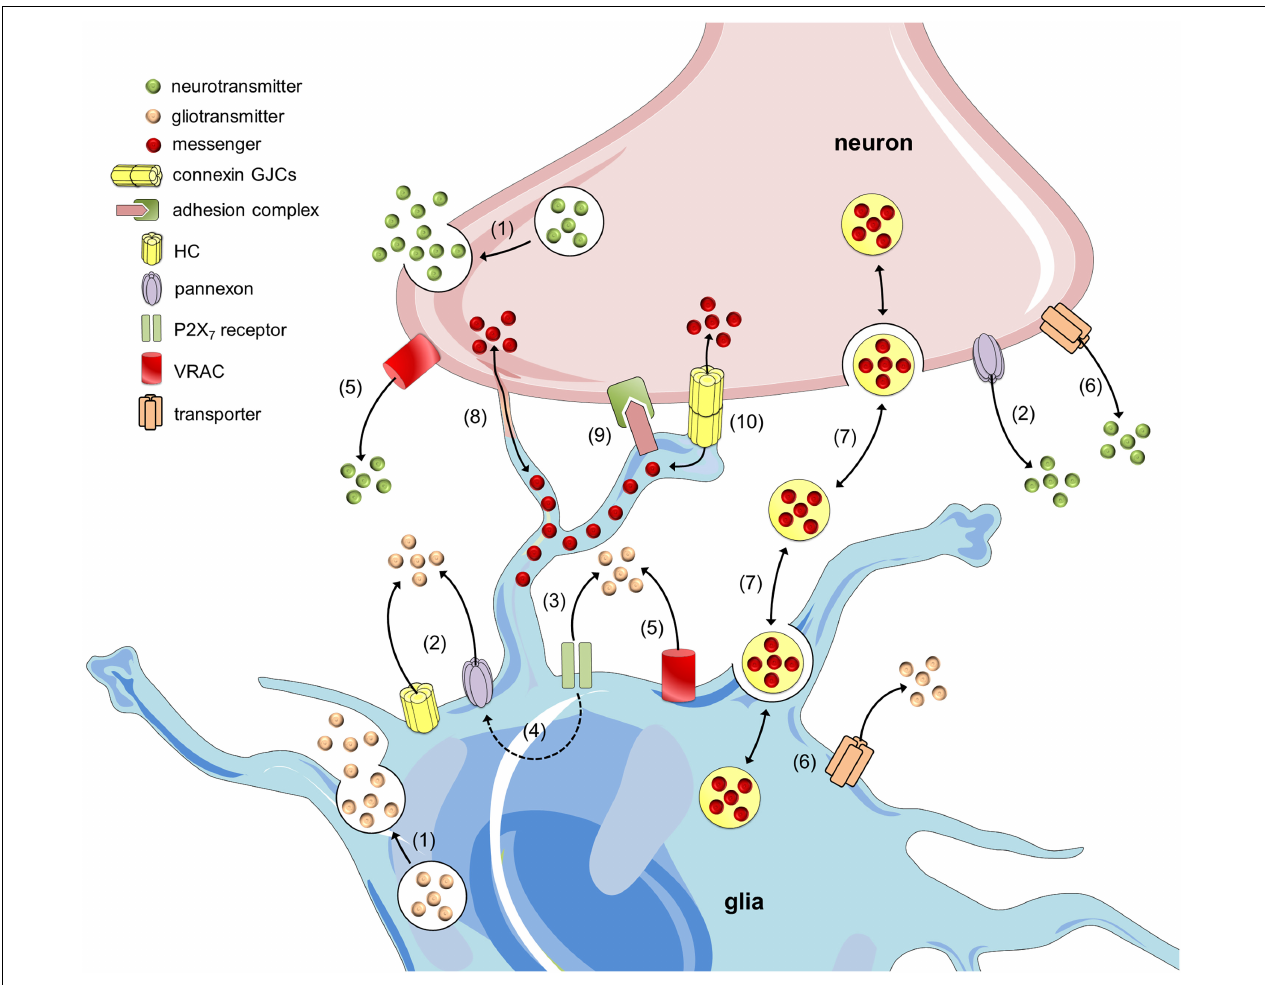
FIGURE 1 | Mechanisms of neuron-glia crosstalk. Glial cells and neurons release neurotransmitters and gliotransmitters through Ca 2 + - and SNARE-dependent exocytosis, respectively (1). In addition to this mechanism, the release of transmitters may occur through alternative non-exocytotic ways. For instance, the opening of hemichannels (HCs) and pannexons may allow the release of gliotransmitters and neurotransmitters (2) (Kang et al., 2008; Xia et al., 2012). Long-lasting activation of P2X 7 receptors by ATP might lead to the appearance of large currents and the rapid exchange of large molecules, including the release of gliotransmitters (3). One theory states that P2X 7 receptor conductance dilates over the time and thereby allows the passage of large molecules; however, another hypothesis states that ATP activates a second non-selective permeabilization pathway (Baroja-Mazo et al., 2013). Recently, it was shown that pannexons might mediate this permeability for large molecules in astrocytes (4) (Iglesias et al., 2009). Additionally, gliotransmitter and neurotransmitter release may occur through volume-regulated anion channels (VRAC) (5) (Kimelberg et al., 1990; Fields and Ni, 2010) and different carriers and/or co-transporters acting normally or in reverse (6) (e.g., excitatory amino-acid transporters, the cysteine-glutamate antiporter and the D -serine/chloride co-transporter) (Rossi et al., 2000; Wu et al., 2007). Within the last decade, a growing body of evidence has indicated that glial cells can also communicate with neurons and vice versa via the release of vesicles (e.g., exosomes, microparticles and apoptotic bodies), containing different cellular messengers (e.g., mRNA, viruses and organelles) (7) (Chivet et al., 2012; Fruhbeis et al., 2013). Adjacent glial cells and neurons can communicate directly through F-actin-based transient tubular connections known as tunneling nanotubes (8) (Wang X. et al., 2012), via cell-to-cell contacts between membrane-bound ligand molecules and their receptors (9) (Avalos et al., 2009) or aggregates of intercellular channels known as gap junctions, which